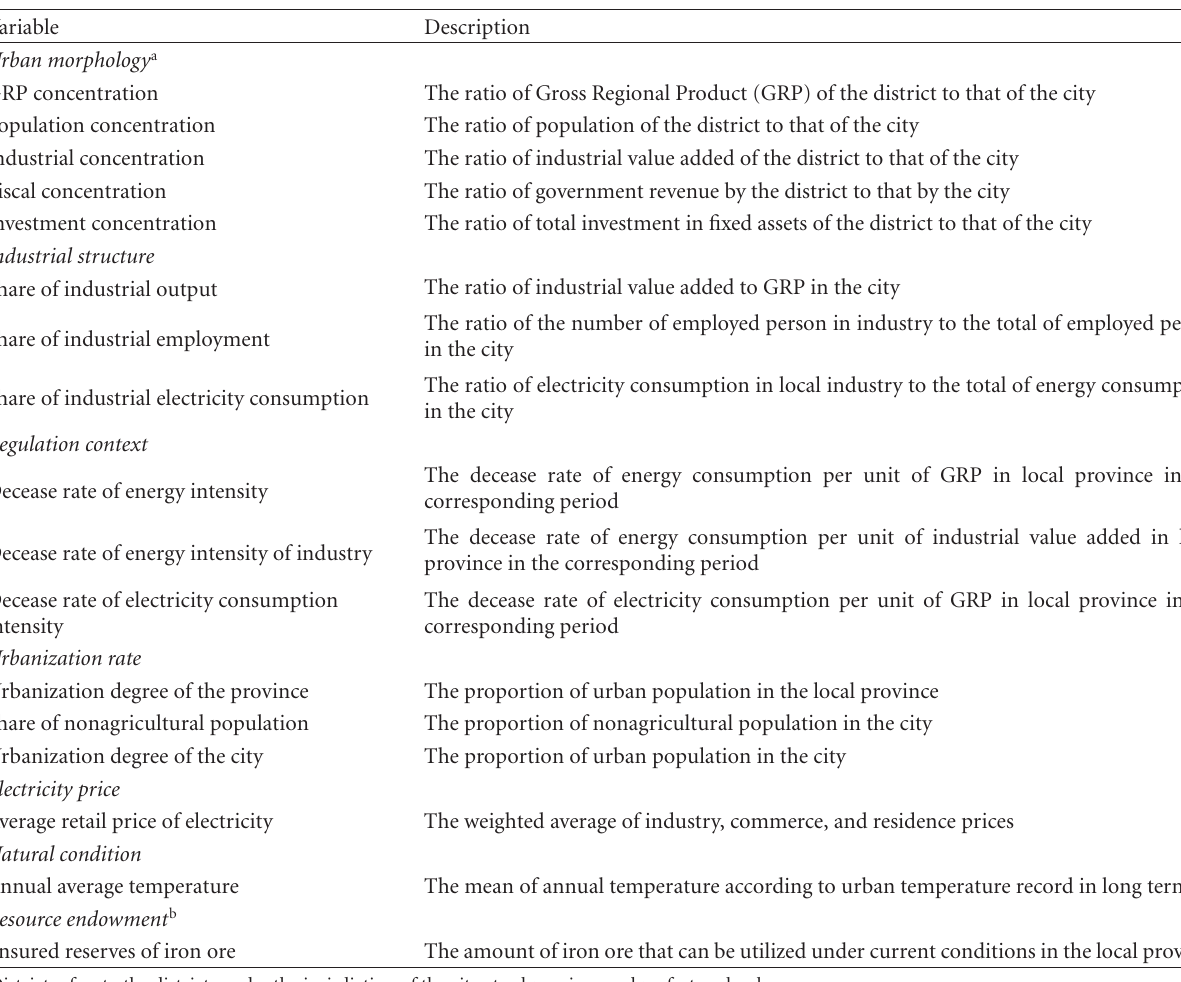
Table 2: Description of explanatory variables and category